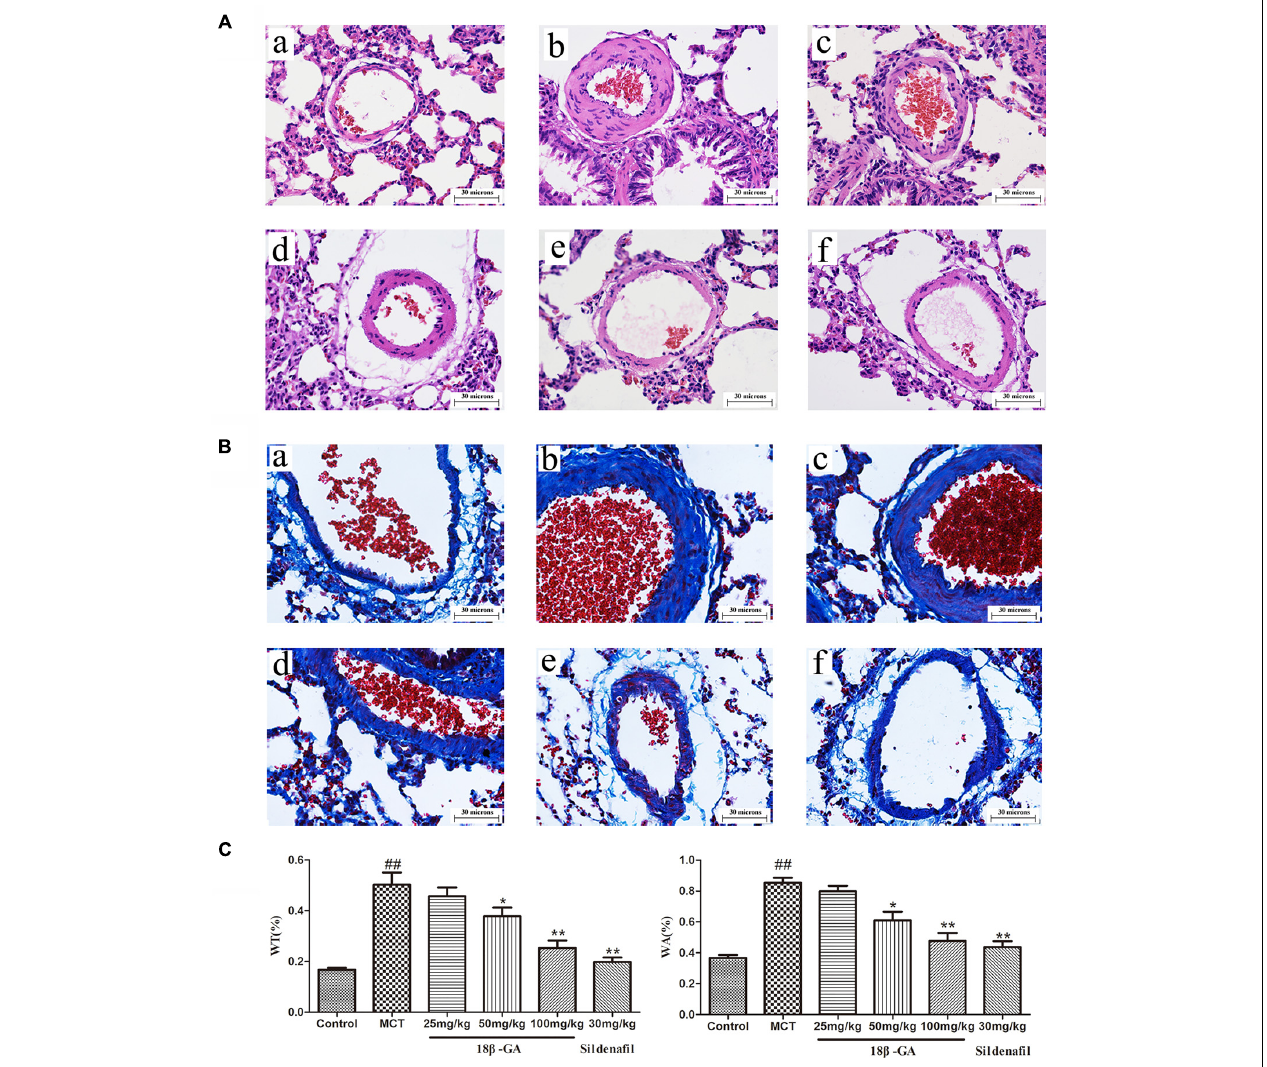
FIGURE 6 | Effect of 18 β -glycyrrhetinic acid on MCT-induced pulmonary vascular remodeling. Representative photomicrographs of pulmonary small arteries by H&E staining (A) and Masson staining (B) (magnification 400 × ): (a) control group; (b) MCT group; (c) 18 β -GA 25 mg/kg group; (d) 18 β -GA 50 mg/kg group; (e) 18 β -GA 100 mg/kg group; (f) Sildenafil 30 mg/kg group. (C) Left: Effect of 18 β -GA on WT%, Right: Effect of 18 β -GA on WA%. Data are expressed as mean ± SEM ( n = 10). ## p < 0.01 vs. control group, ∗ p < 0.05, ∗∗ p < 0.01 vs. MCT group. MCT, monocrotaline; 18 β -GA, 18 β -glycyrrhetinic acid; WT%, the ratio of the vascular walls thickness; WA%, the ratio of the vascular wall